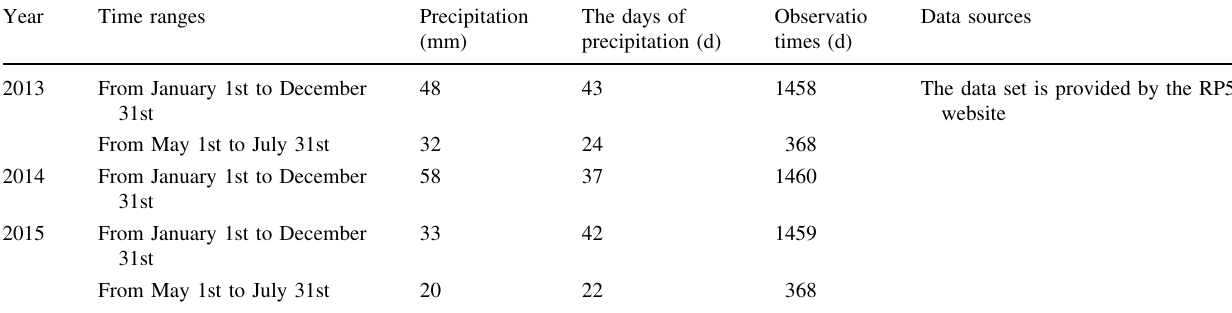
Table 5 Statistical table for precipitation